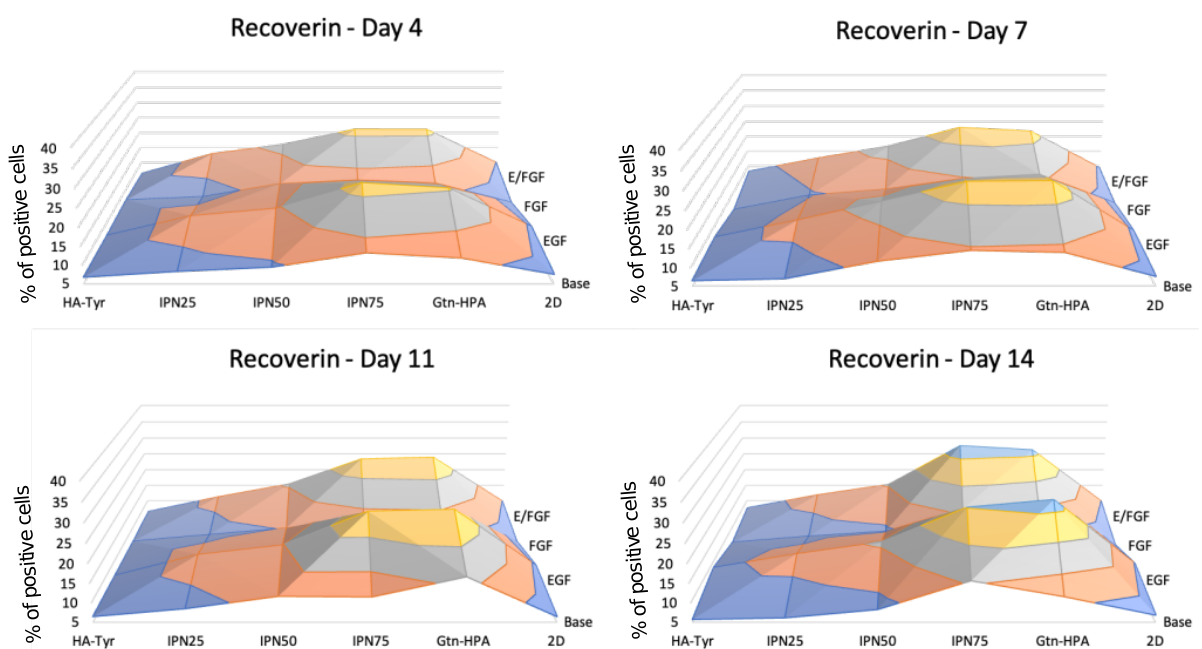
Figure 7. Photoreceptor expression (recoverin) in hRPCs cultured in hydrogels. Cells were cultured for 2 weeks and phenotype was analyzed at day 4, 7, 11, and 14 for n = 5 replicates with flow cytometry. Map surfaces show the medium component on the x -axis (base medium, EGF, FGF, or both), the tissue culture on the y -axis (2D, Gtn-HPA, IPN75, IPN50, IPN25, and HA-Tyr) and the expression of recoverin is shown on the z -axis.